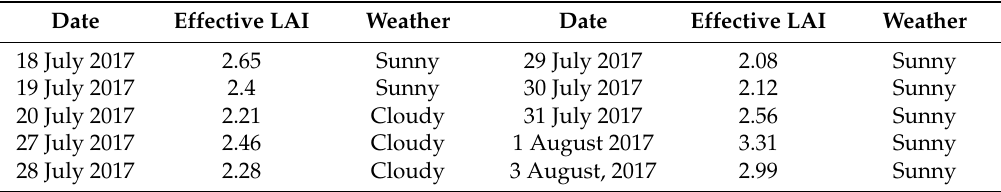
Table 3. The average effective LAI values on different